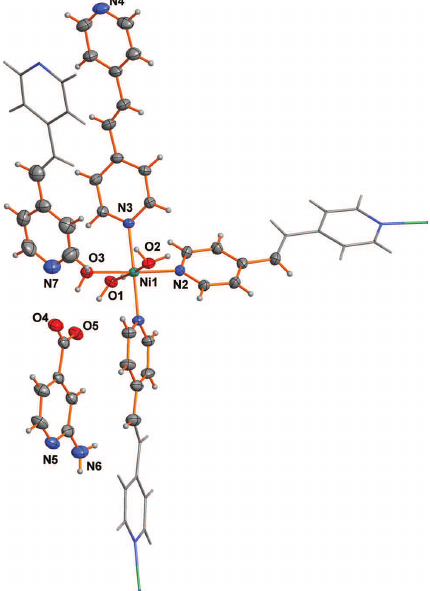
Table 1: Data collection and